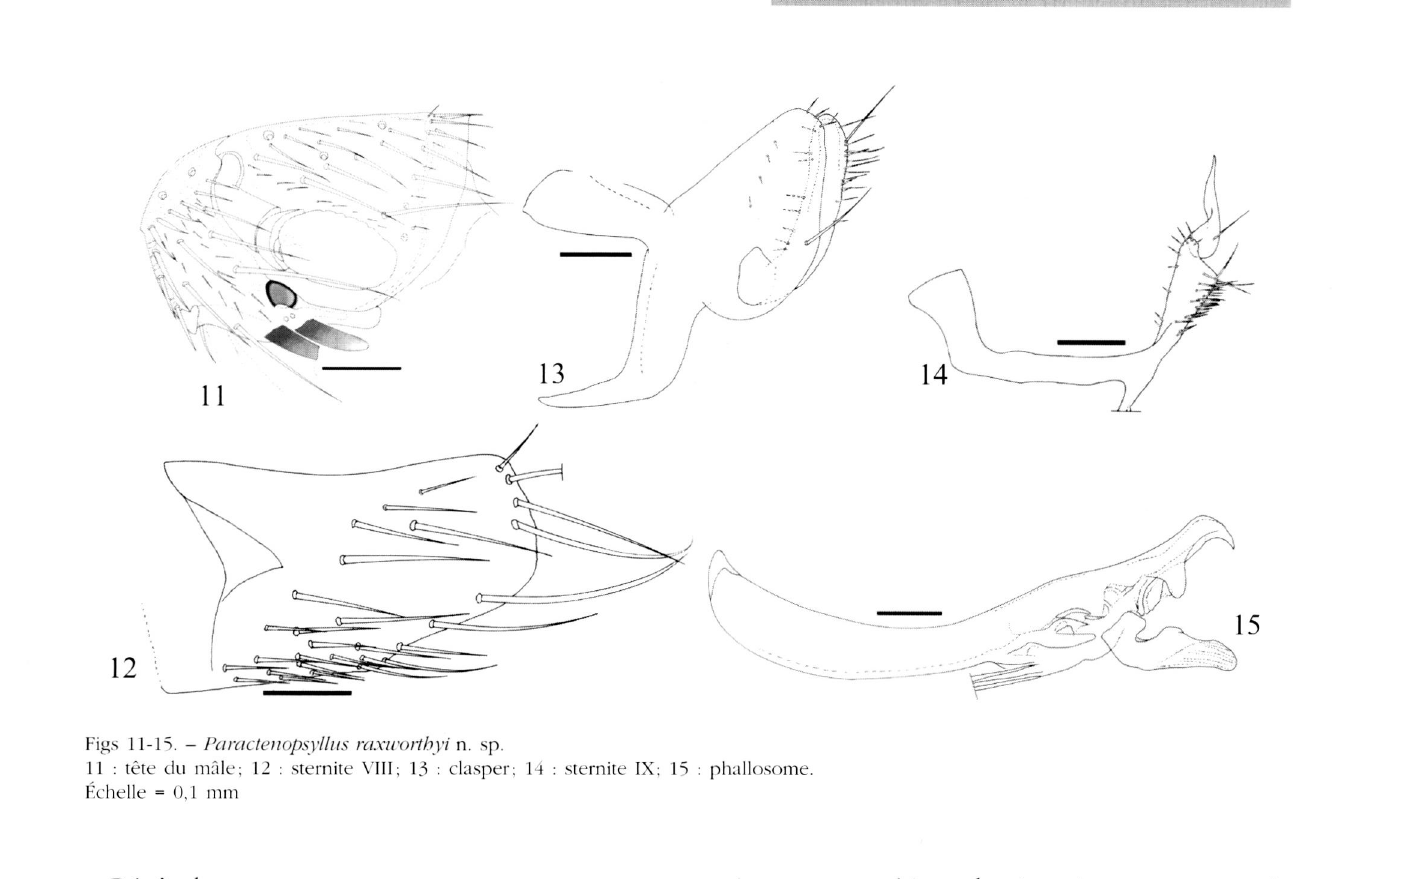
Fïgs L1-1S. - Particlviiopsyllits raxworthyi n. sp. Il : tête du mâle; 12 : sterilite VIII; 13 : clasper; 1-i : sterilite IX; И : phallosome. Échelle = 0, 1